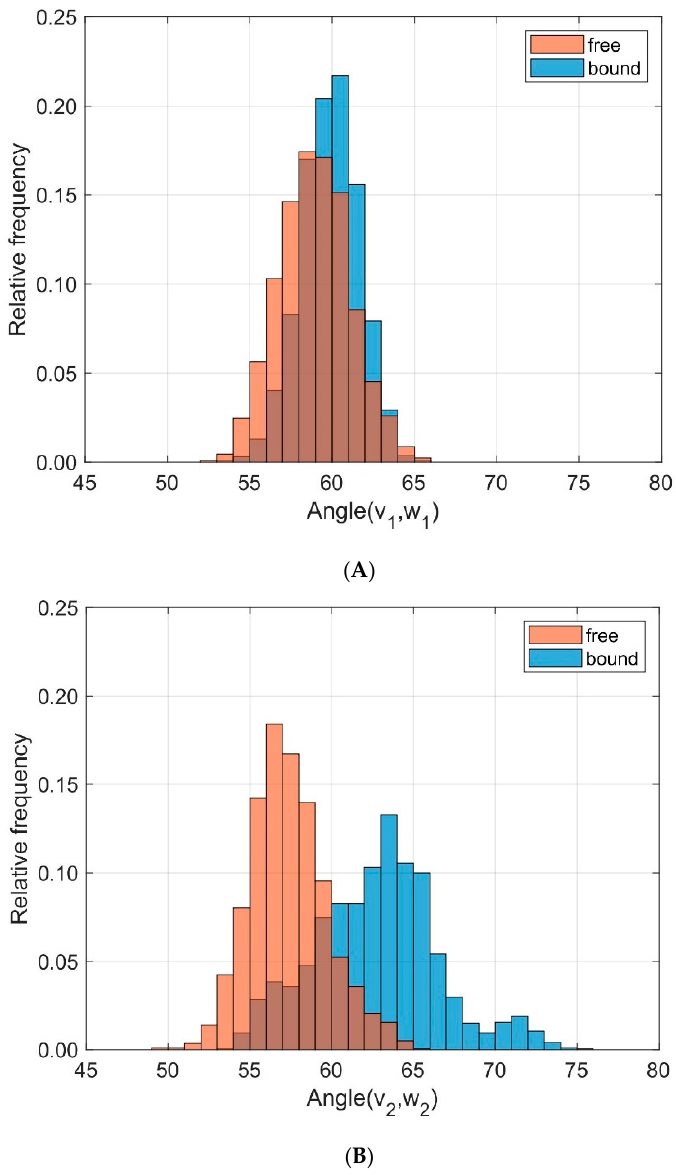
Figure 5. Frequency distribution of angles between corresponding principal component eigenvectors of domains TCR V α and TCR V β for bound (blue) and unbound states (orange). ( A ): Angles between eigenvectors v 1 , w 1 corresponding to the main extensions ( D = 0.215); ( B ): Angles between v 2 , w 2 ( D = 0.643).